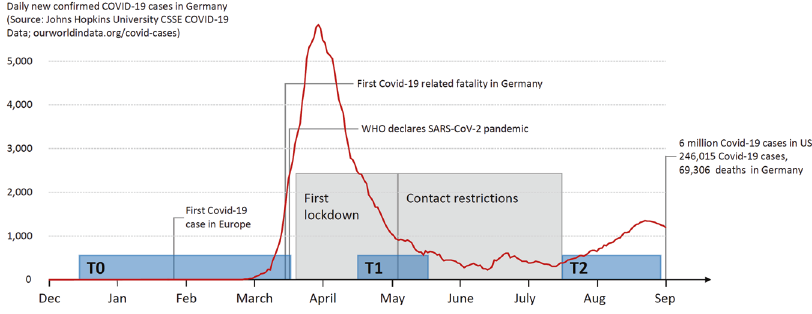
Fig. 1 Testing timeline relative to important milestones in the pandemic timeline in Germany. Data collection took place before and during the very early stages of the Covid-19 pandemic, prior to the fi rst Covid-19-related fatality in Germany (T0: 12/14/2019 – 03/10/2020), during the fi rst lockdown period (T1: 04/11/2020 – 05/08/2020), and during the subsequent period of contact restrictions (T2: 07/10/2020 – 08/